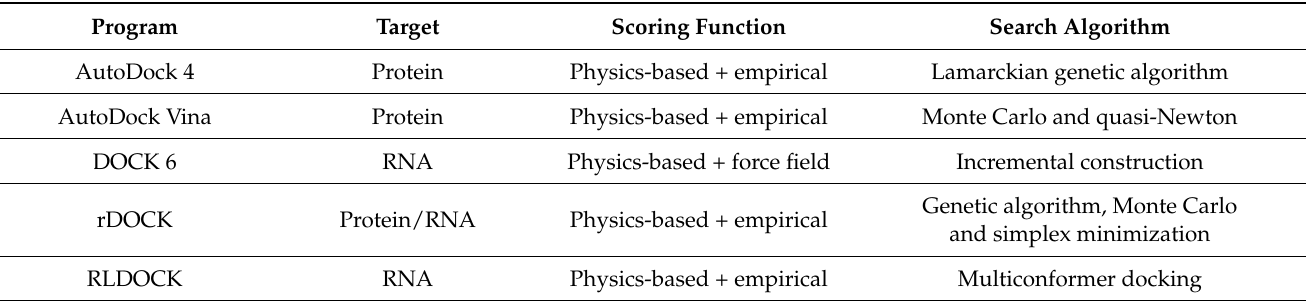
Table 1. Summary of the target, scoring functions, and search algorithms of the programs tested in the